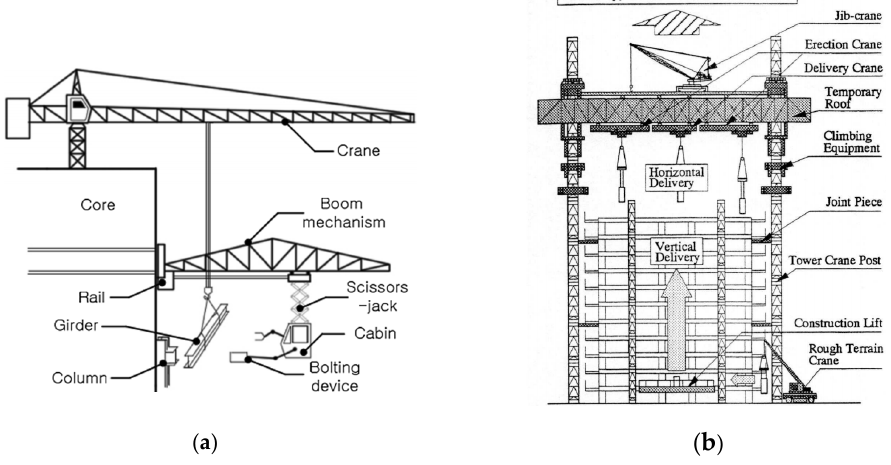
Figure 5. ( a ) RBA system [122]; ( b ) The Big Canopy automation system [123].